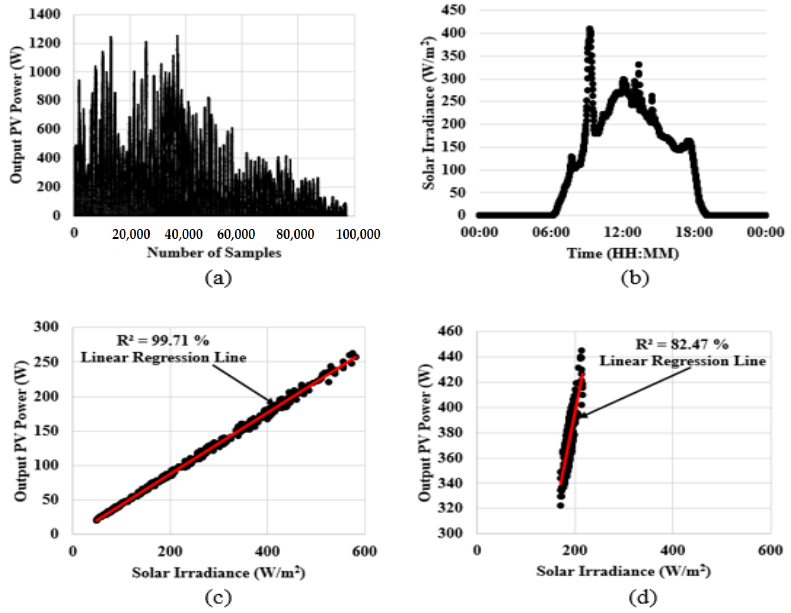
Figure 2. ( a ) All datasets captured over 10 weeks; ( b ) visual presentation of how the measured power changed over the day; ( c ) optimal correlation in the dataset; ( d ) worst correlation in the dataset.